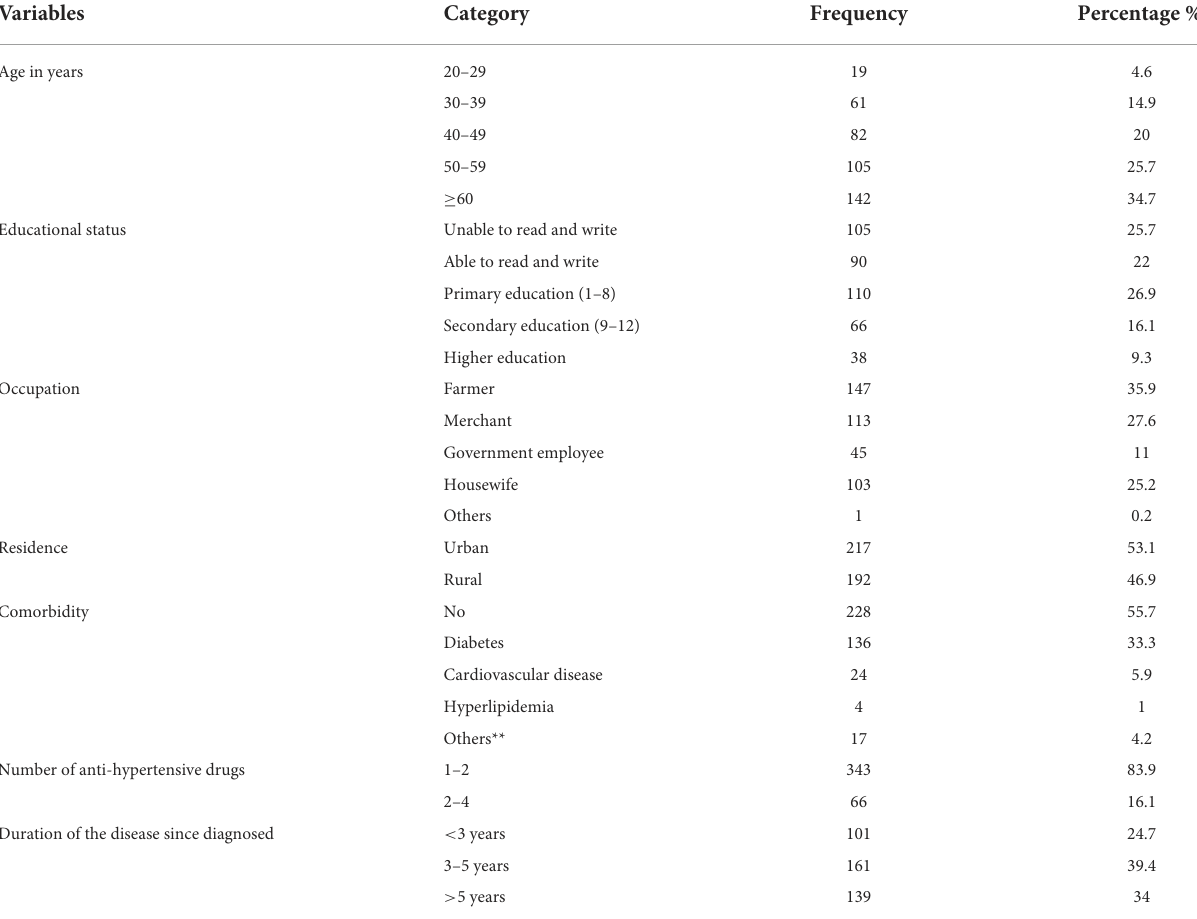
TABLE 1 Socio-demographic characteristics and basic clinical characteristics of hypertensive patients at West Arsi public health facilities, 2021 ( N = 409). Variables Category Frequency